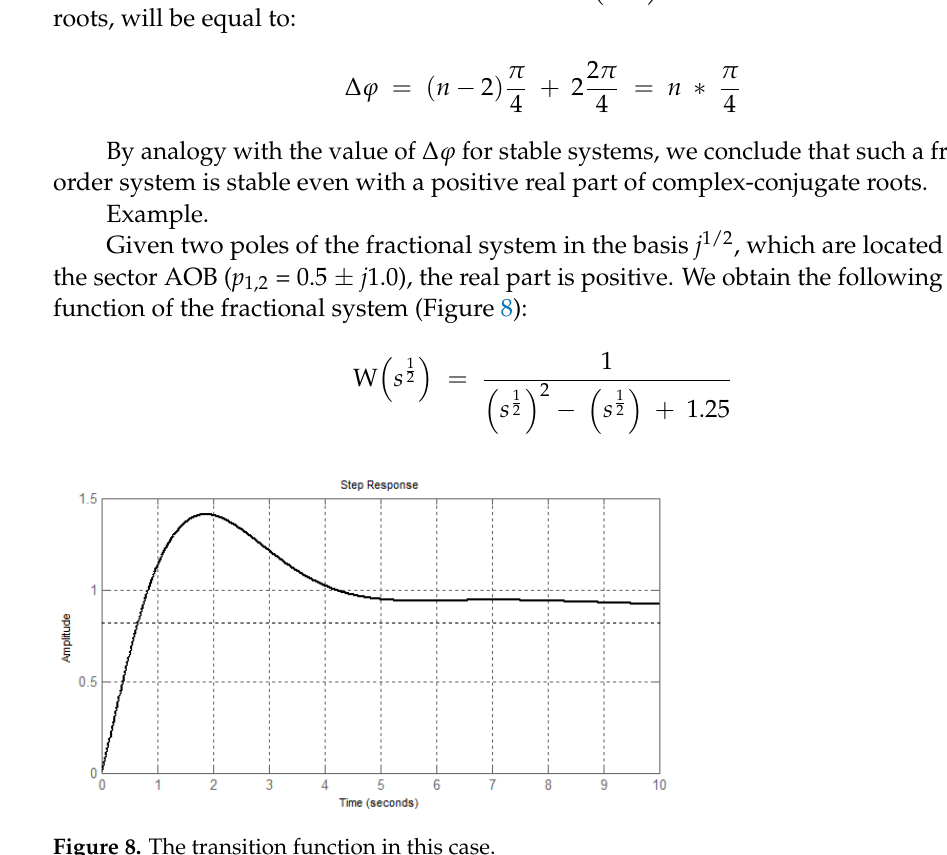
Figure 7. Vector displacement for the first two complex-conjugate roots for the case when 𝜔 𝜖 (0, ∞) .